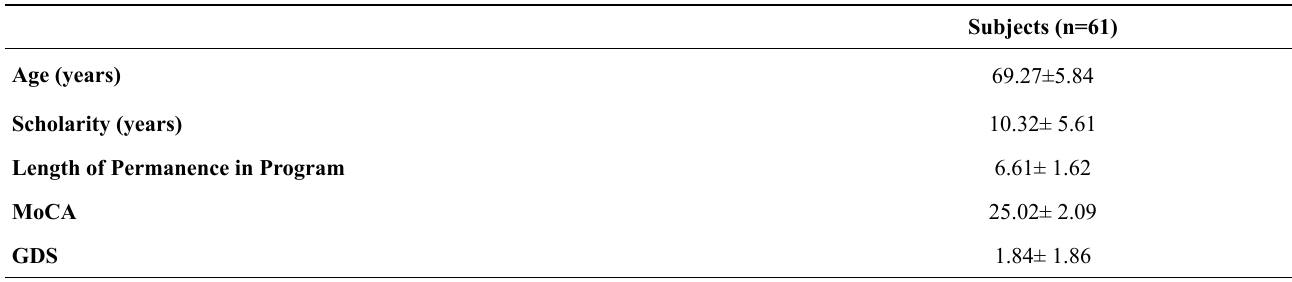
Table 1. Clinical characteristics of